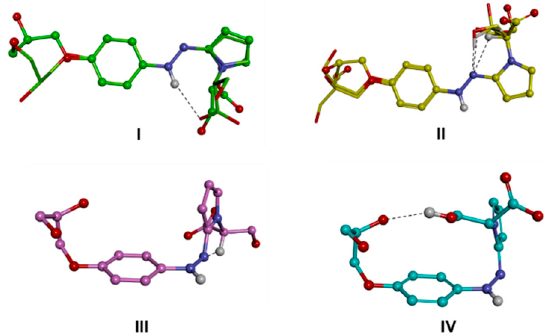
Figure 6. ( I – IV ) conformational families of the zwitterionic form of d 1RR . The lowest energy conformer of each family is displayed as a ball and sticks. Conformers belonging to subfamilies are superimposed by phenyl ring atoms and displayed as a stick. Heteroatoms are coloured by atom type: O, red; N, blue. Hydrogens are omitted for clarity with the exception of those involved in intramolecular interactions (evidenced with a black dashed line).